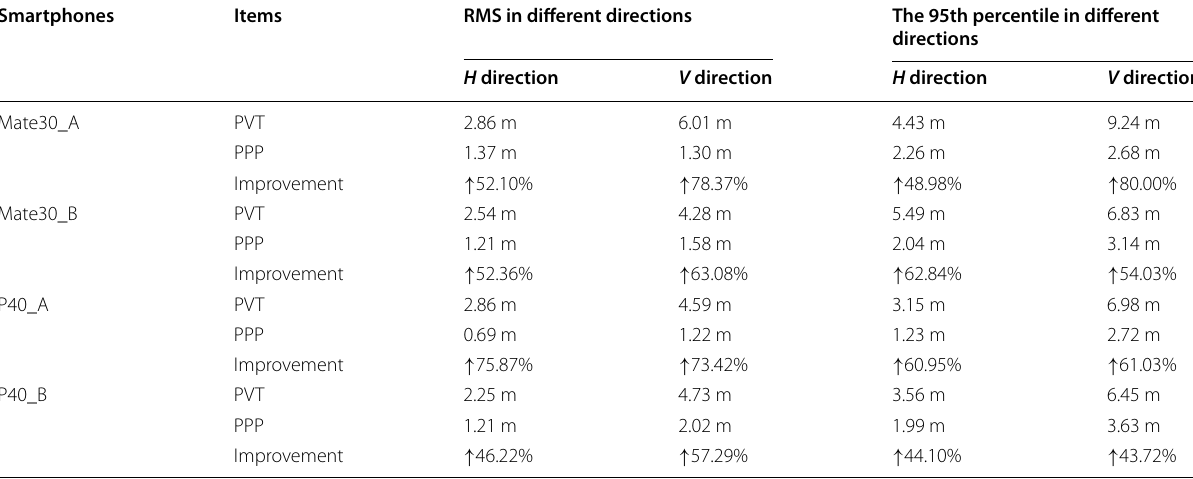
Table 6 Statistics of the positioning accuracy of PPP and PVT results in the vehicle-roof mode